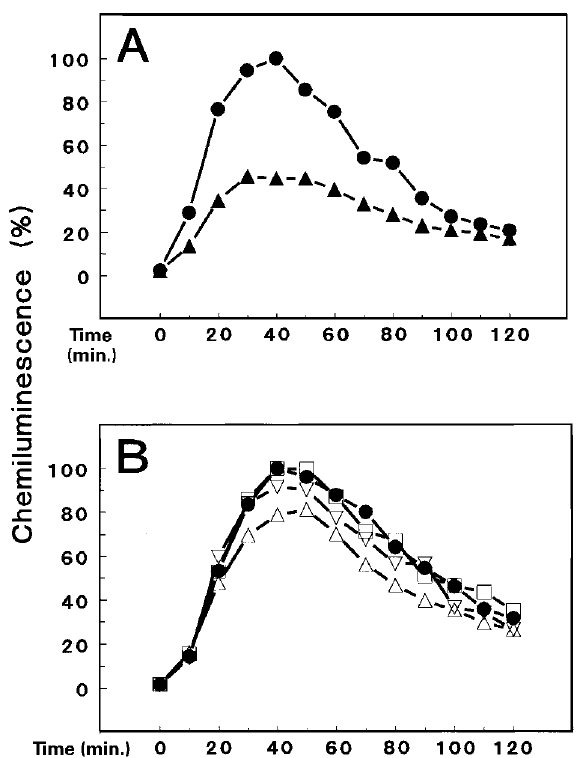
FIG. 3. Interaction between nitric oxide and superoxide released from tracheal preparations. ( A ). Zymosan-induced chemiluminescence generation by isolated guinea-pig two ring tracheal preparations in the absence ( d ) or presence of sodium nitroprusside ( m ). ( B ). Zymosan-induced chem- iluminescence generation in the presence of 100 m M hista- mine by isolated guinea-pig two ring tracheal preparations in the absence ( d ) or presence of L-arginine ( n ), L-N G -nitro- arginine ( , ) or a combination of L-arginine and L-N G -nitro- arginine ( h